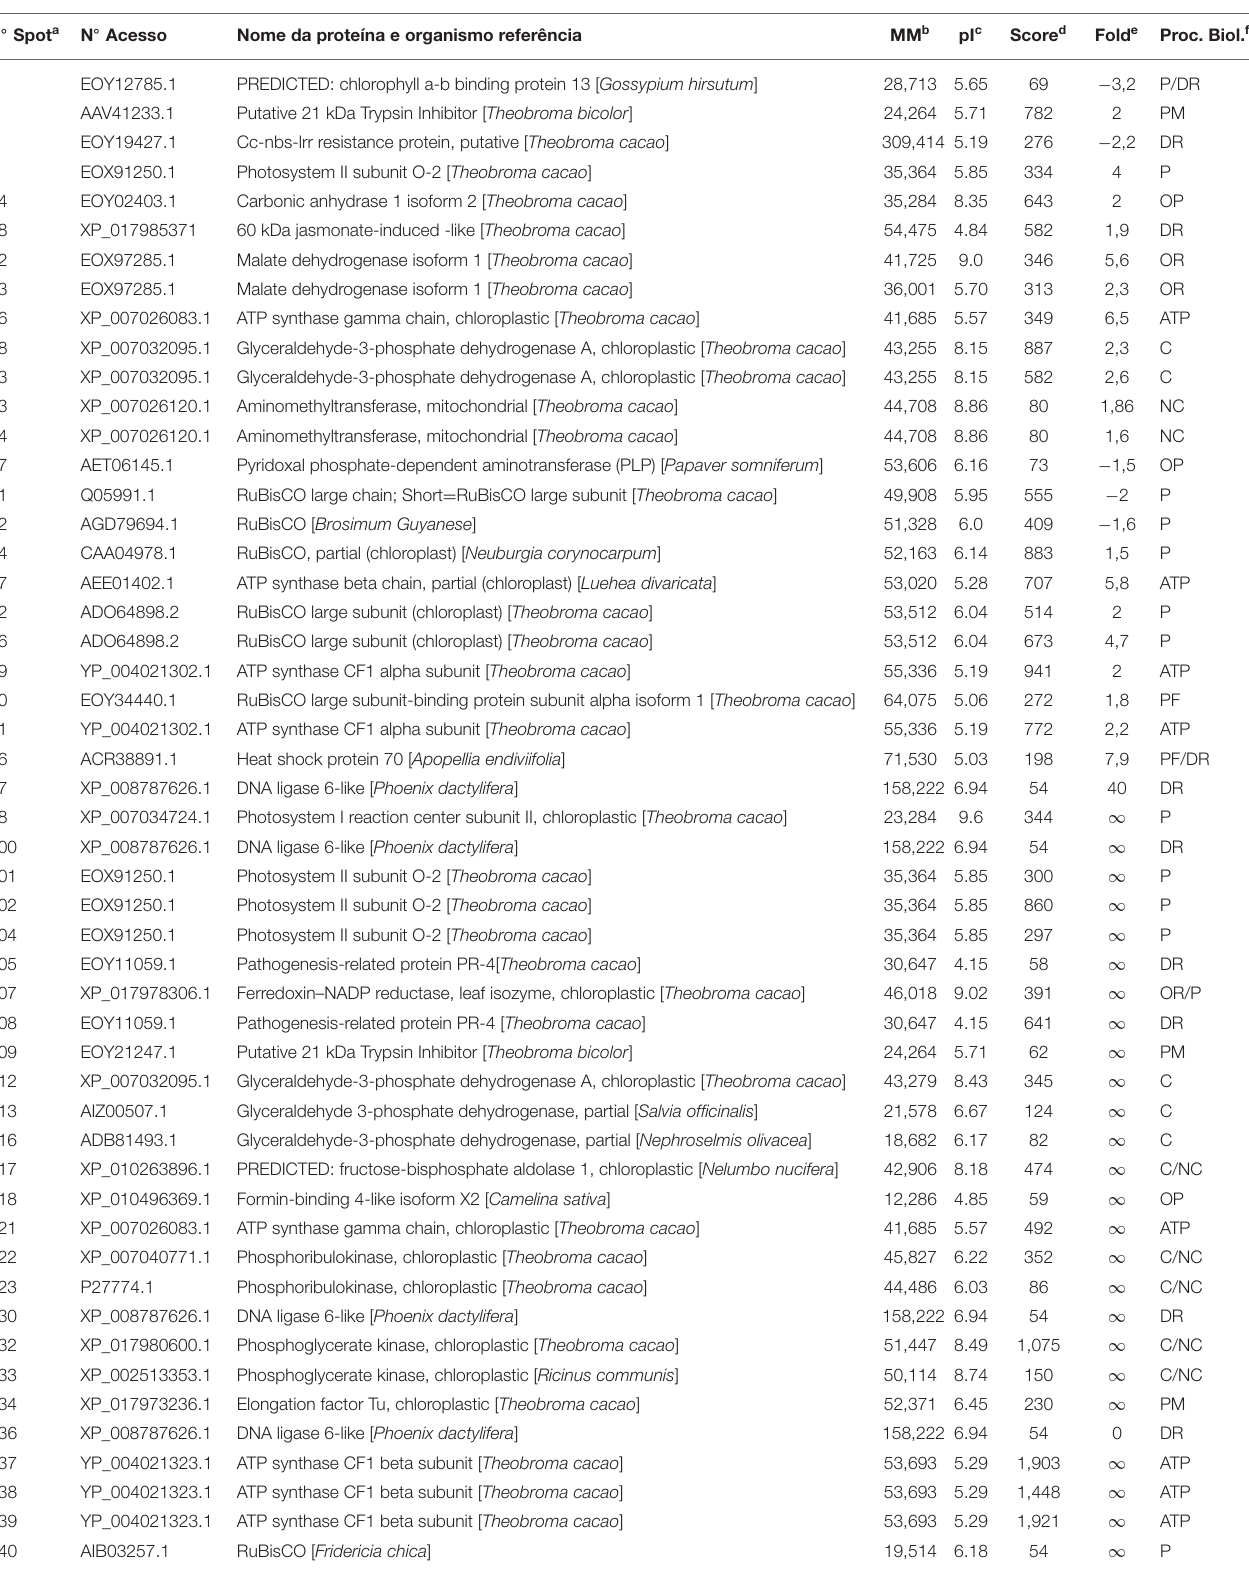
TABLE 2 | Proteins identified through mass spectrometry in leaves of the SIC 23 susceptible clone of T. cacao inoculated and not inoculated with P. palmivora. N ◦ Spot a N ◦